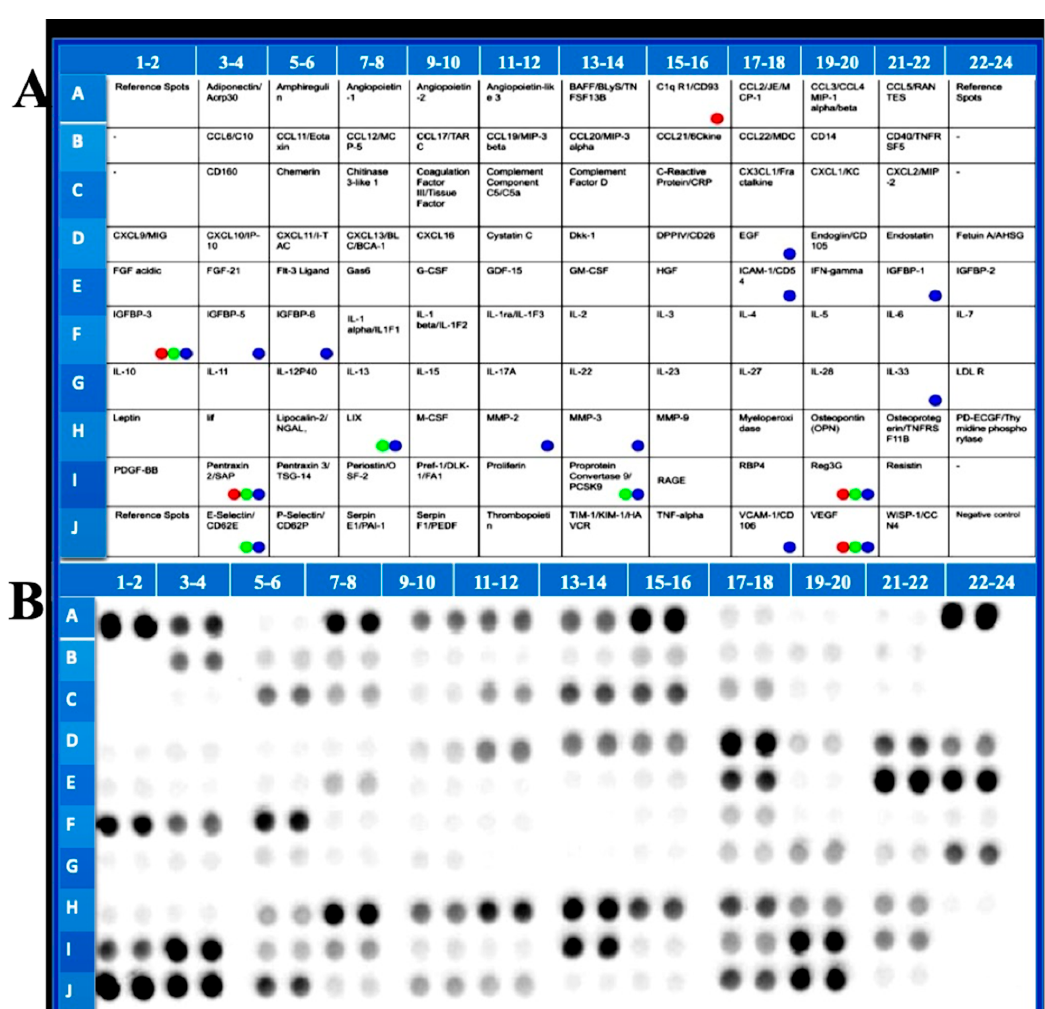
Figure 3. The list of cytokines measured by cytokine array ( A ). Colored dots indicate a statistically significant decrease by drug treatment. Representative array blot ( B ).